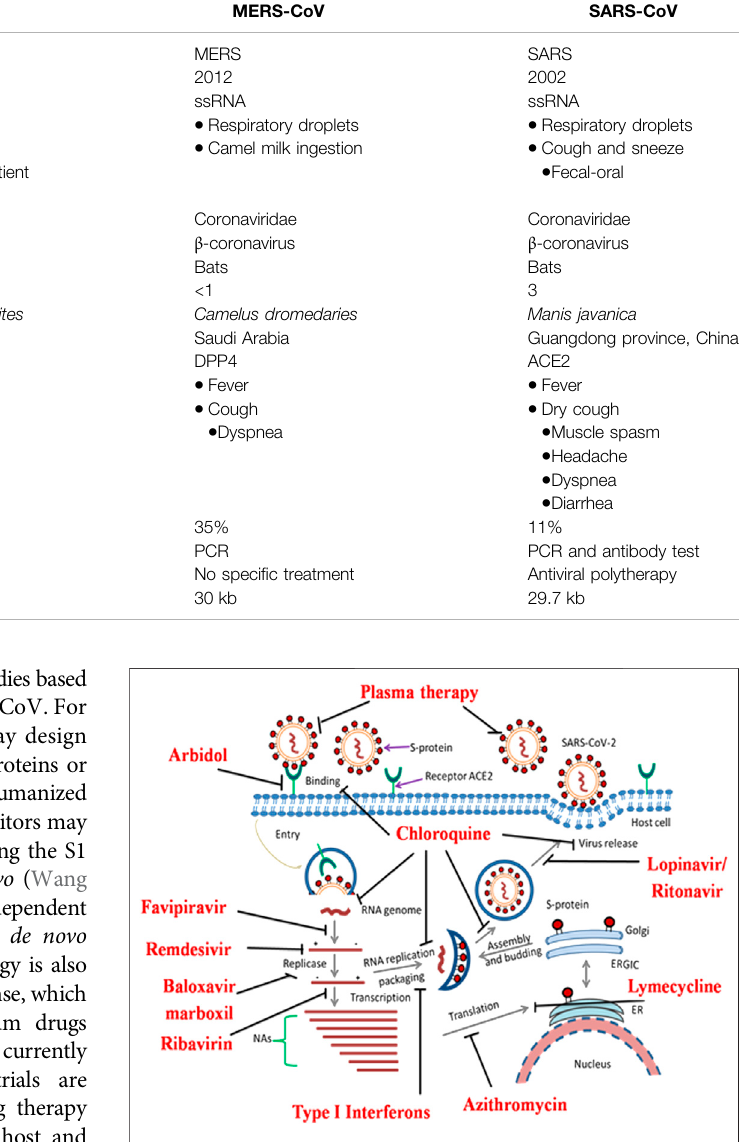
FIGURE 2 | Overview of the novel SARS-CoV-2 pathogenesis and potential molecular targets for repurposed anti-COVID-19 drugs undergoing clinical trial studies. SARS-CoV-2 interacts with the host cellular receptor (ACE2). Later, virion particlesgainentryintothetargetcellsandundergoendocytosis.Insidethecell, due to low endosomal pH, the virus capsid disintegrates and the virion genome is released in the cytoplasm for protein synthesis mechanism. After the release of genomicRNA,itundergoestranslationandreplicationformingsub-genomicmRNAs. Thelattertranslatesintoavarietyofstructural(S,E,M,andN)proteinsandaccessory proteins in the endoplasmic reticulum (ER). RNA genome and a variety of cellular proteins undergo the formation of a new virus particle in the ER-Golgi intermediate compartment(ERGIC).Finally,thenewvirionparticlesareassembledandreleased via exocytosis for further pathogenesis. Re-proposed medications and their possible molecular targets against COVID-19 are depicted by bold